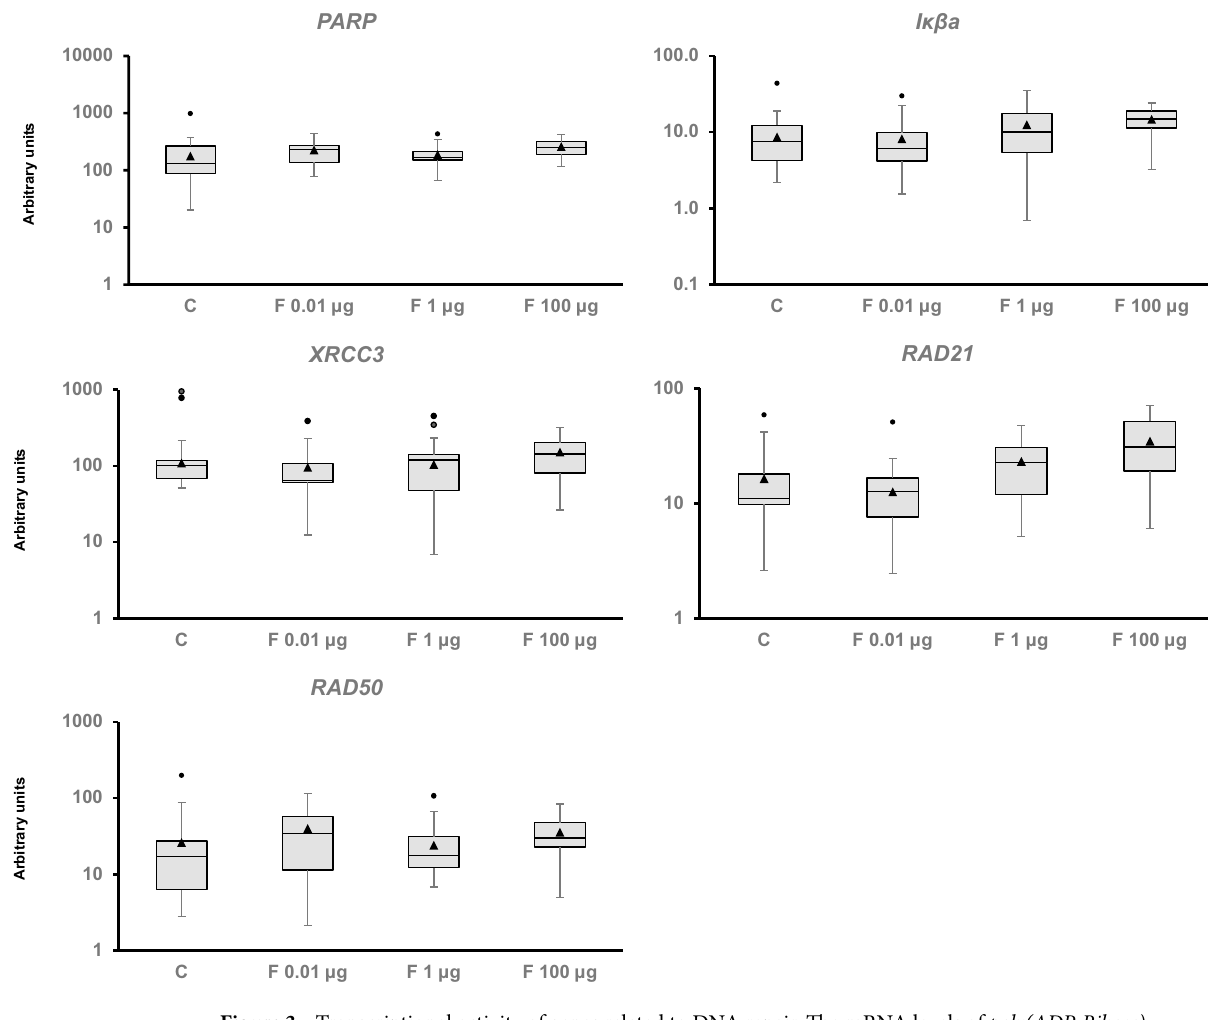
Figure 3. Transcriptional activity of genes related to DNA repair. The mRNA levels of poly(ADP-Ribose) polymerase I ( PARP1 ), NFKB inhibitor Iκβ ( IkBa ), X-ray repair cross complementing 3 ( XRCC3 ), RAD21 Cohesin Complex Component ( RAD21 ), and RAD50 Double Strand Break Repair Protein ( RAD50 ) in Physella acuta adults after in vivo exposure to Fenoxycarb for seven days at 19 °C are shown. RT-PCR was used to quantify the mRNA levels and ribosomal protein L10 ( rpL10 ), actin ( Act ), 6-phosphofructo-2-kinase/fructose- 2,6-biphosphatase 2 ( PFKFB2 ), and glyceraldehyde-3-phosphate dehydrogenase ( GAPDH ) were used as reference genes. The comparison was performed with the solvent-exposed controls. Whisker boxes are shown. Each box corresponds to 12 individuals. The median is indicated by the horizontal line within the box, and the 25th and 75th percentiles are indicated by the boundaries of the box. The highest and lowest results are represented by the whiskers. The small triangle inside the box denotes the mean, and the outliers are shown (circles). No significant differences were observed relative to the control (p <